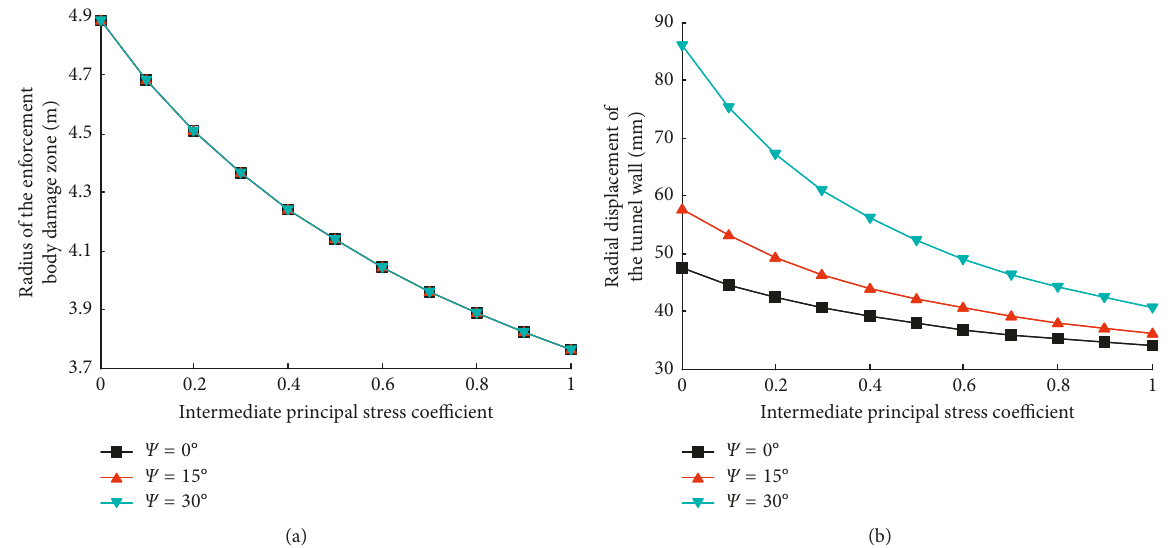
Figure 11: Influence of the rock’s dilatancy angle and intermediate principal stress on the surrounding rock deformation: (a) radius of the surrounding rock reinforcement body damage zone; (b) radial displacement of the tunnel